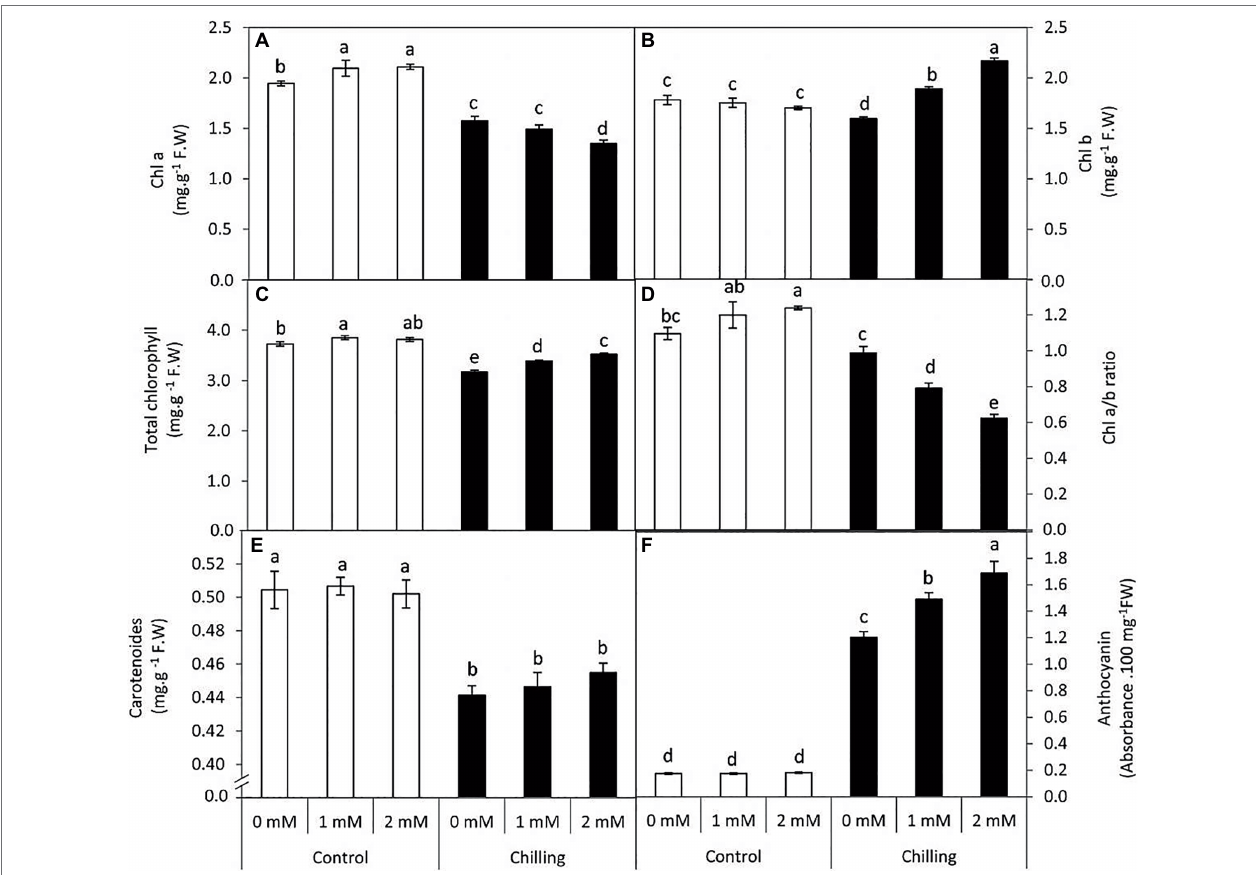
FIGURE 2 | Effect of γ -aminobutyric acid (GABA) as a foliar application at 1 and 2 mM on leaf pigments concentration of tomato plants cv “Super marmende” growing under normal (25°C/20°C day/night ) and chilling conditions (5 days/4ºC for 6 h/day) followed by 2 days recovery. (A) , chlorophyll a; (B) , chlorophyll b; (C) , total chlorophyll; (D) , chlorophyll a/b ratio; (E) , carotenoids, and (F) , anthocyanin. Data followed by the same letters ± SE are not significant according to Duncan multiple rang test at P ≤ 0.05. The white columns refer to the control conditions and the black columns refer to the chilling